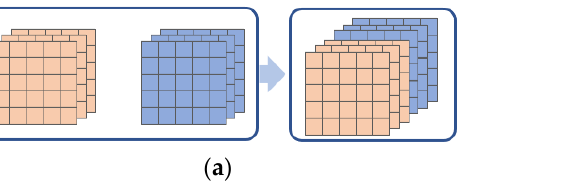
Figure 9. Method of feature fusion: ( a ) feature cascade; ( b ) feature element-wise sum. The structure of the decoder part is symmetrical with respect to the encoder part.